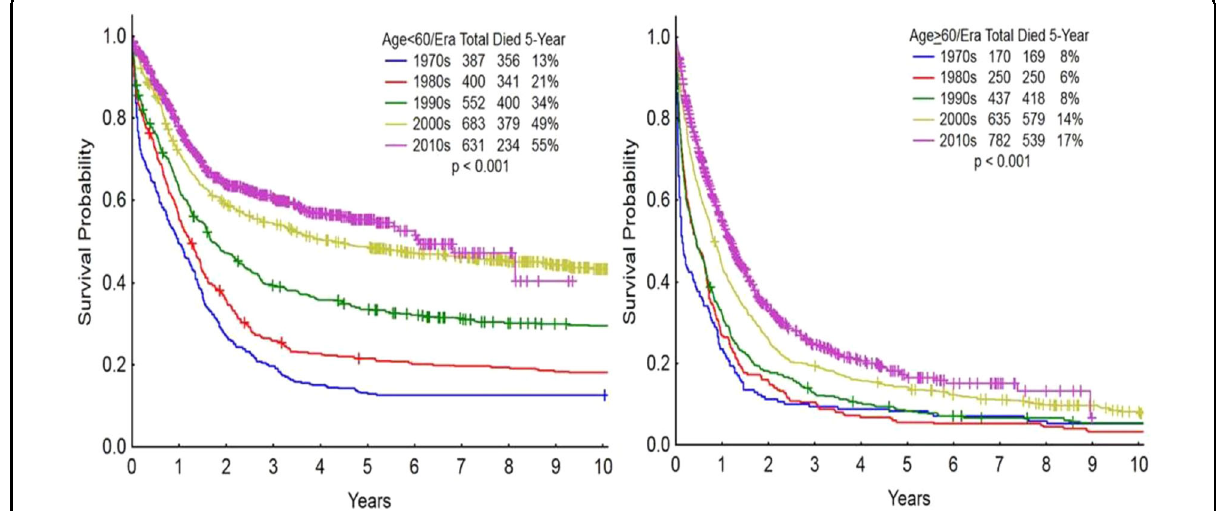
Fig. 1 Survival of de novo acute myeloid leukemia at MD Anderson (1970 – 2017) by Age and Treatment Era: Left panel: age<60 years; Right panel: age 60 +